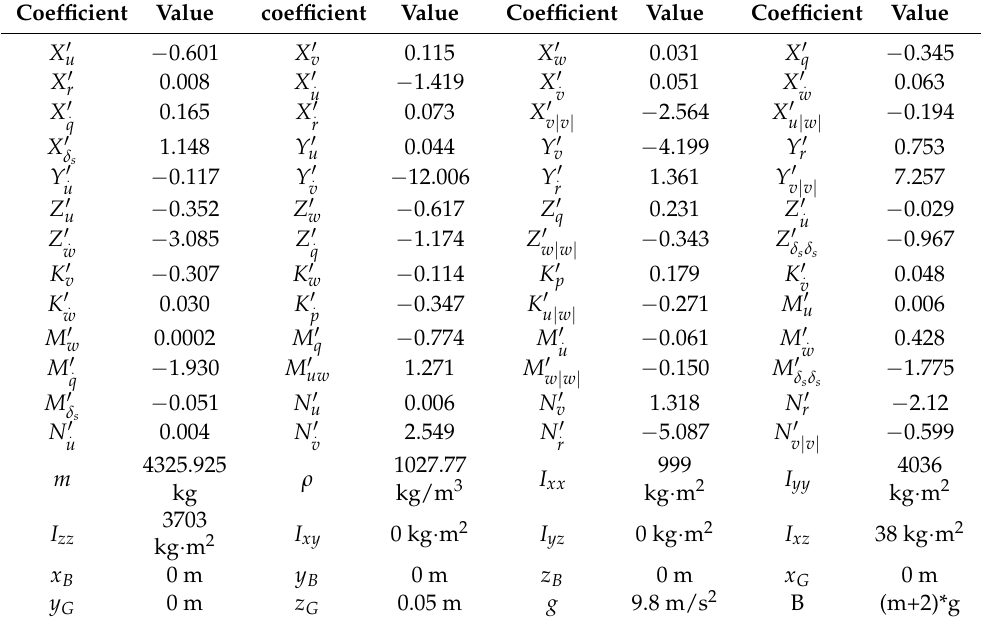
Table A1. Dynamic parameters of the Haidou-1 ARV.